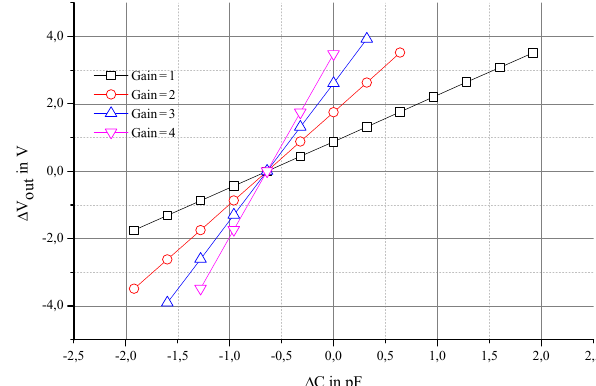
Figure 8. Measured capacitance to voltage transfer curves for the four gain settings.